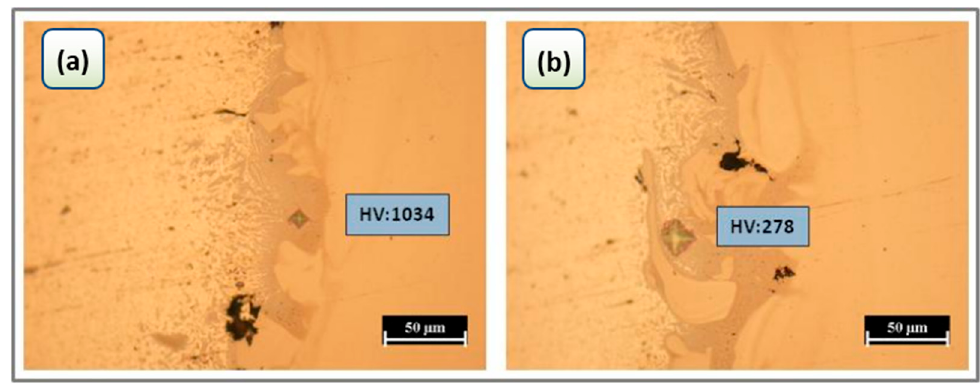
Figure 14. Optical micrographs of joint s1 shows the result of Vickers micro-hardness measurements on the interface aluminum/steel: ( a ) hardness value due to IMC ( b ) hardness value due to effects of the IMC and Al matrices.